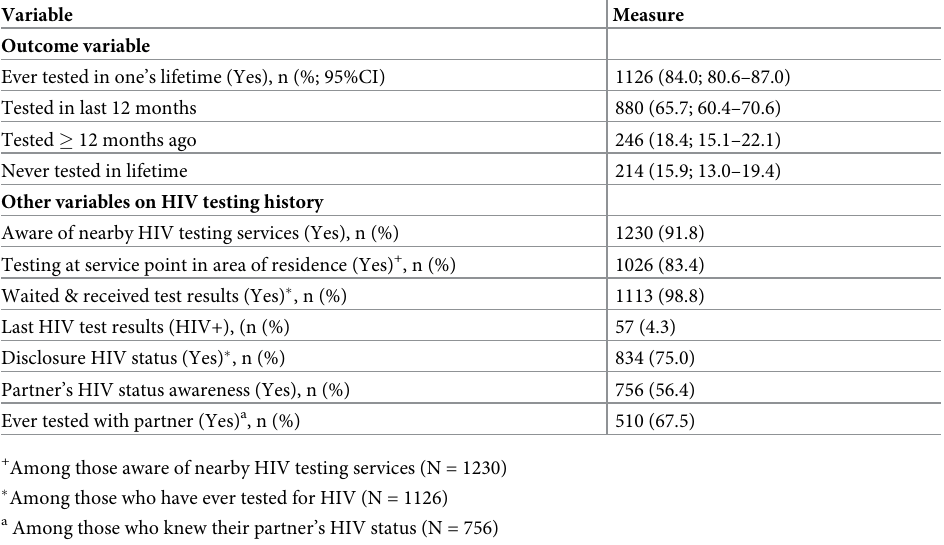
Table 2. HIV testing history among male survey participants from selected villages in Mpigi district, August to September 2018 (N =